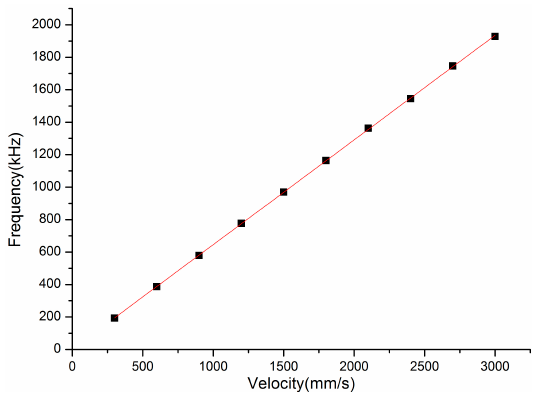
Figure 3. The simulated frequency of the external moving target at different velocities with θ = 60°.